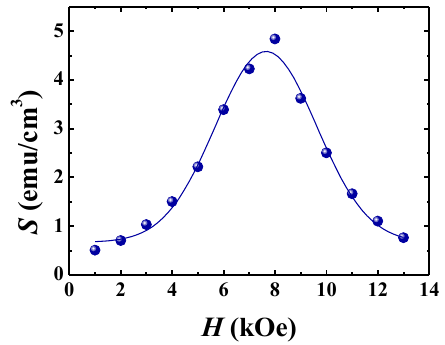
Fig. 5. Field dependence of viscosity S at T = 300 K. Solid line is a guide for the